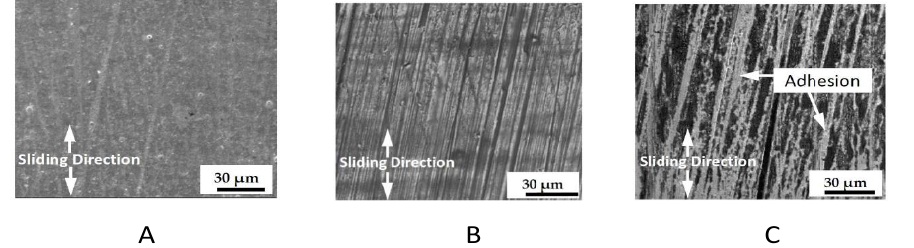
Figure 1. Cr electroplated piston ring friction wear scars under different static loads. ( A ) Load 50 [N]; ( B ) Load 290 [N]; ( C ) Load 400 [N] [4].